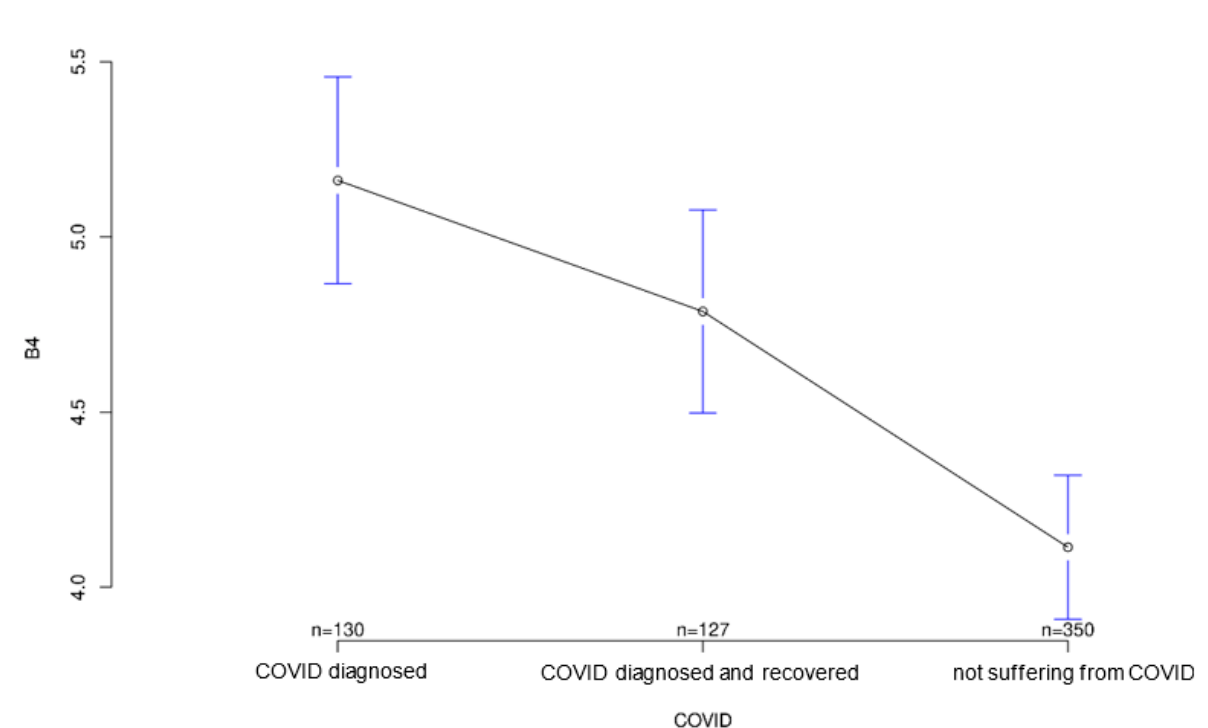
Figure 5. Average agreement with statement 3 of the COVID-specific questionnaire: “Body-worn sensor technology would always remind me of illness and thus would certainly be a psychological burden.” The y -axis shows the mean result of participants choice on the Likert scale.